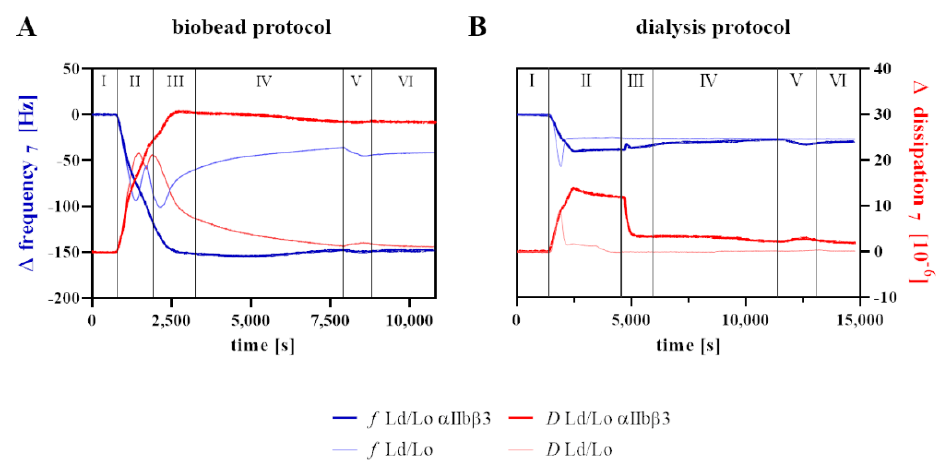
Figure 5. Representative QCM graphs visualizing the experimental setup using Ld/Lo proteoliposomes prepared by the ( A ) biobead or ( B ) dialysis protocol. Changes in frequency (blue) and dissipation (red) of the seventh overtone were recorded at 37 ◦ C. After baseline stabilization (I) liposomes (Ld/Lo-thin line) or proteoliposomes (Ld/Lo α IIb β 3-thick line) were injected (II) and bilayer formation was induced using AH-peptide (III). The bilayer was treated with the respective buffer (i.e., biobead or dialysis buffer ± Mn 2+ ) (IV). PAC-1 antibody (5 µ g/mL) was injected (V), followed by rinsing with the respective buffer (VI).